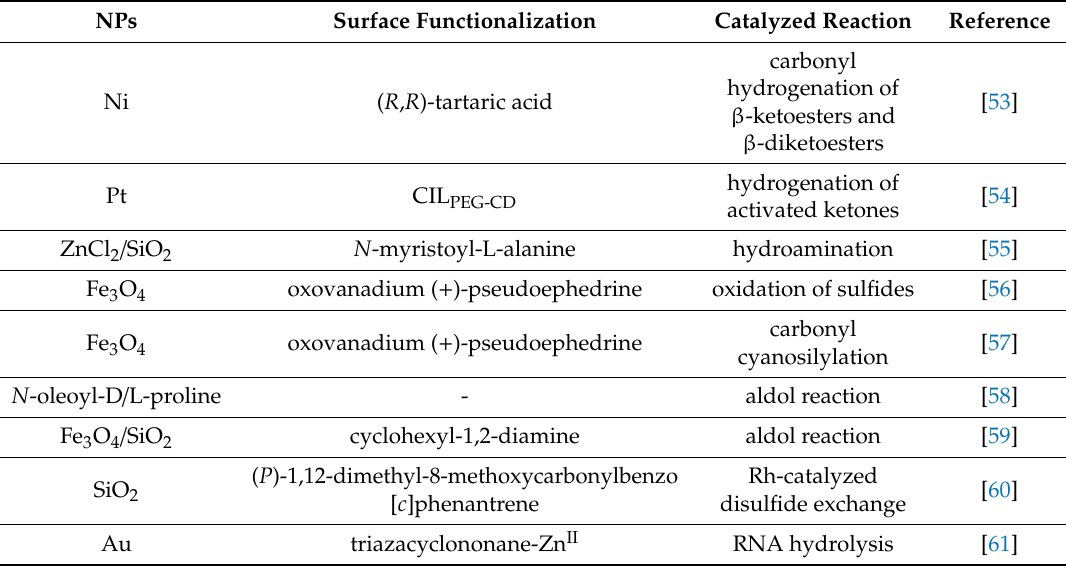
Table 2. Main applications of chiral NPs for the asymmetric catalysis and their principal